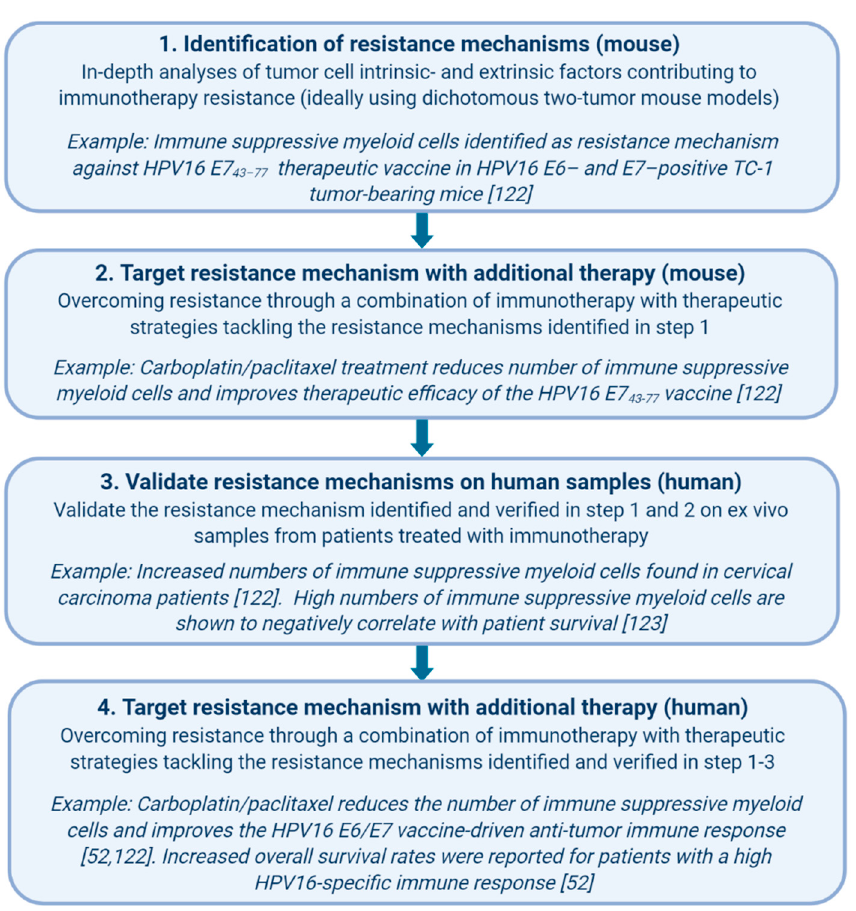
Figure 2. A workflow for the identification and validation of immunotherapy resistance mechanisms. Created with BioRender.com.